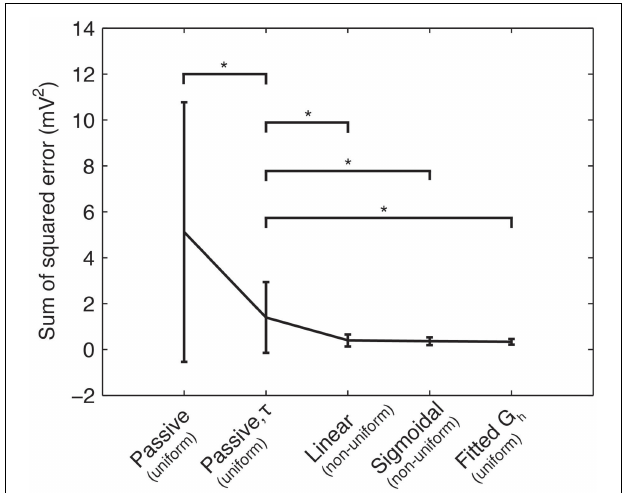
FIGURE 4 | Sum of squared errors between the model and experimental traces across different optimization procedures. Means and standard deviations of sum-of-squared error measure (mV 2 ) between model and experimental somatic membrane voltage response across four categories of model fitting: R m and C m only (“Passive”); R m , C m , and activation time constant for I h (“Passive, τ ”); R m , C m , τ , and linear dendritic G h distribution (“Linear”); R m , C m , τ , and sigmoidal dendritic G h distribution (“Sigmoidal”); R m , C m , τ , with k d = 0 (resulting in a uniform dendritic G h distribution), but the baseline G h allowed to vary (“Fitted G h ”). Single stars (“ ∗ ”) denote significant differences in means across categories denoted, according to a two-sample t -test ( p < 0 . 05). For clarity, the dendritic G h distributions (uniform or non-uniform) are denoted in parentheses for each